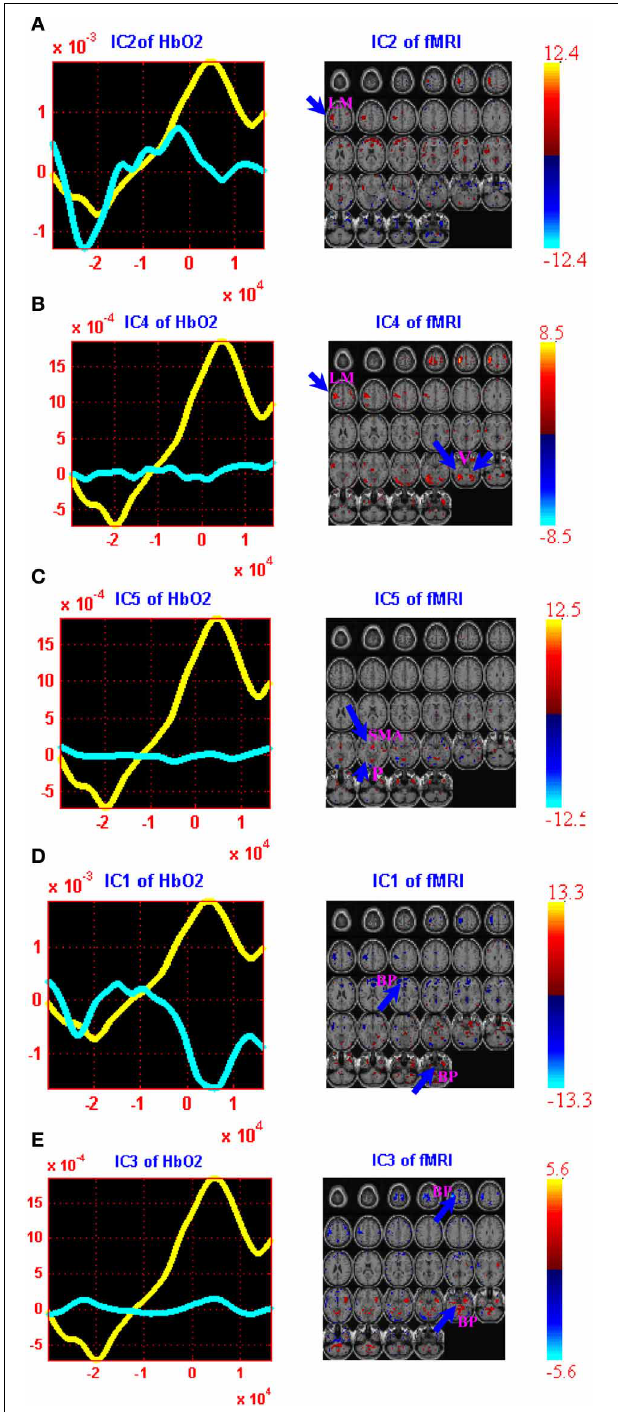
FIGURE 2 | jICA decomposition of (cid:2) HbO 2 and fMRI joint data for right finger tapping tasks: three components were found to be significantly correlated with finger tapping tasks [Independent components (ICs) 2, 4, and 5] while two were well-correlated with the physiology and body movement noise (ICs 1 and 3). Each of these components is shown in a separate panel in the figure: IC2 (A) , IC4 (B) , IC5 (C) , IC1 (D) and IC3 (E) . The fMRI maps are thresholded at | Z | > 1 . 5 for display purposes.